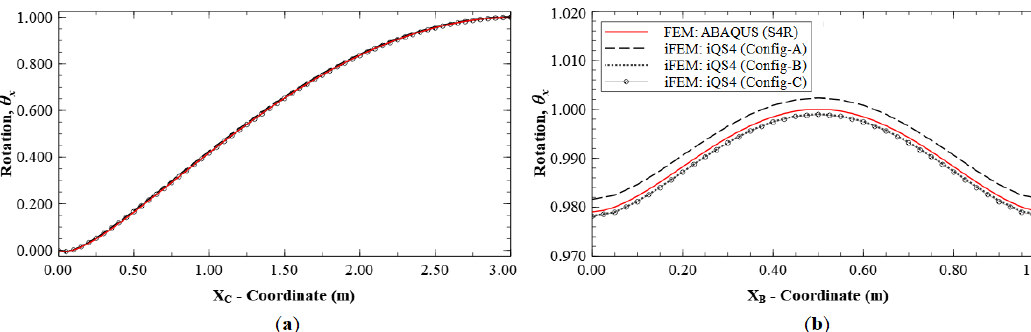
Figure 10. Line plots for rotation ( 𝜃 𝑥 ) for Mode 2 along; ( a ) section C-C’; and ( b ) section B-B’.